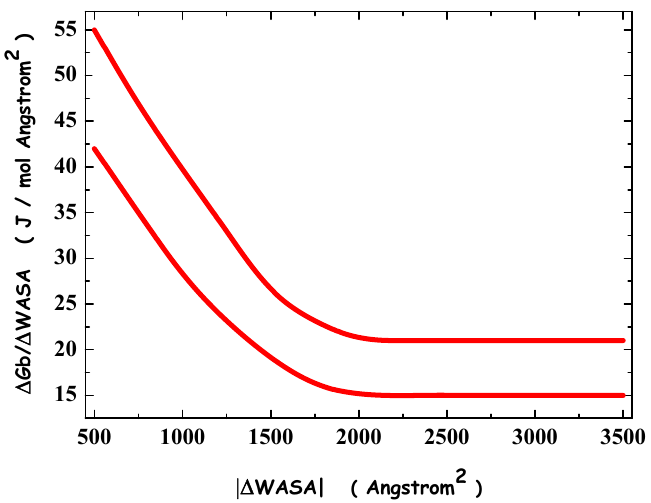
Figure 1. The values of the binding Gibbs free energy change normalized to the buried WASA are plotted versus the values of buried WASA for the 113 non-covalent heterodimers analyzed by Regan and co ‐ workers [7] ; the two curves enclose the region where experimental values occur.